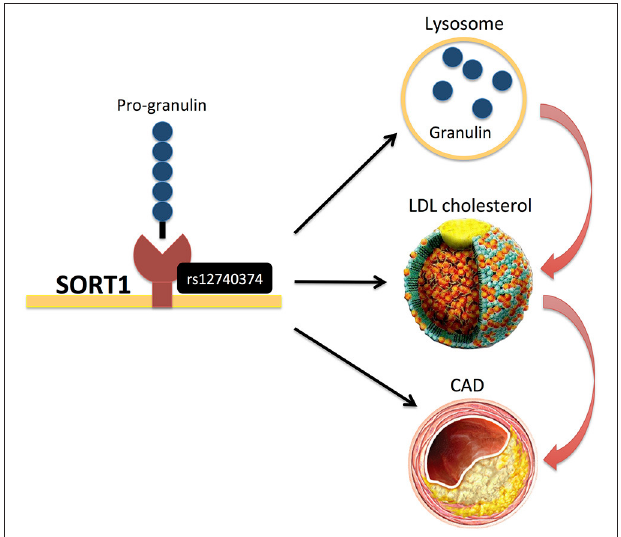
FIGURE 8 | Kraus et al. (42) performed a pathway-level integrative analyses and observed associations of circulating short-chain dicarboxylacylcarnitine (SCDA) with variants in ER stress genes, whereof several genetic variants in FBXO25 and SUGT1 genes also demonstrated evidence of cis-regulation in expression quantitative trait loci (eQTL) analyses and independently predicted CAD